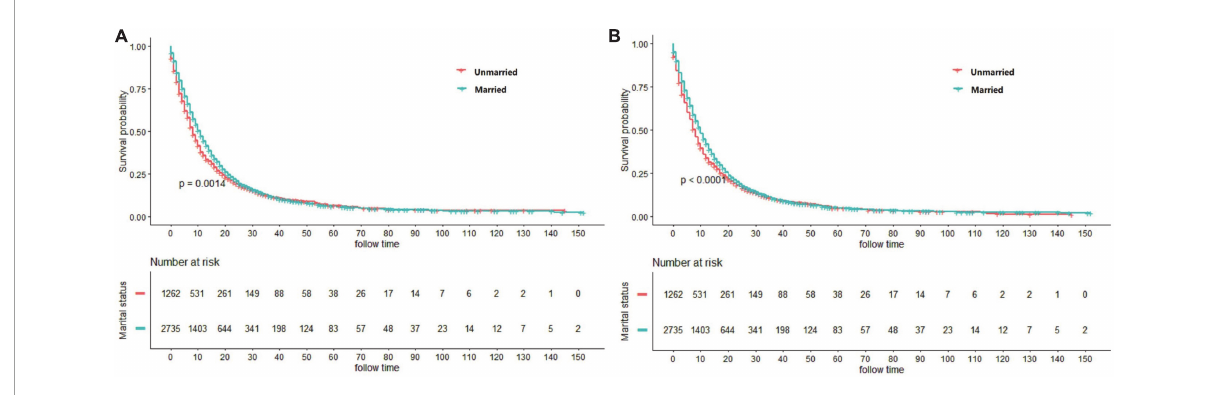
FIGURE2 Kaplan–Meier curves showing cancer-specific survival (CSS) (A) and overall survival (OS) (B) between married and unmarried